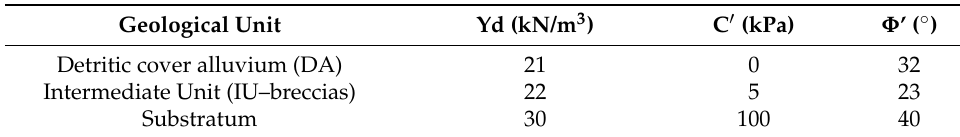
Table 3. Mechanical parameters of the Grand Ilet geological units crossed by the gully of the Ravine de l’Eglise selected after sensitivity analysis. Yd dry unit weight; C’ effective cohesion; Φ ’ effective friction angle.